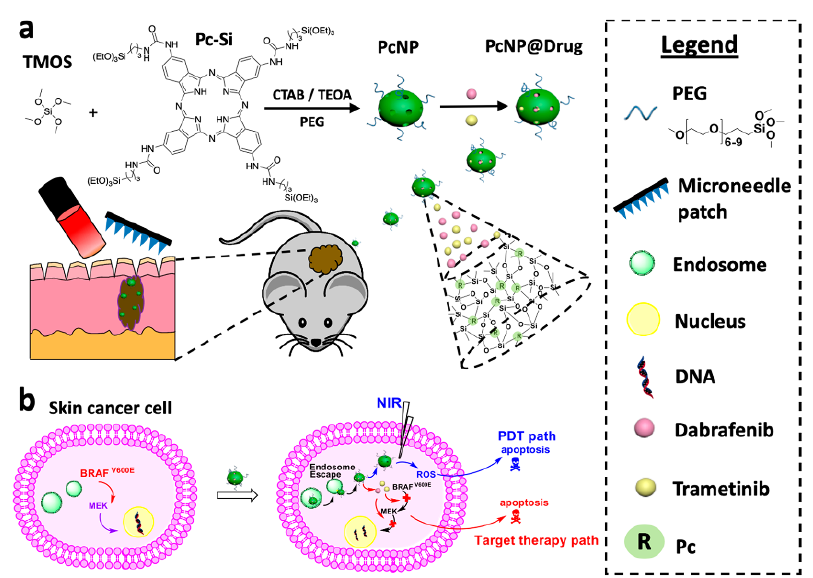
Figure 6. ( a ) PcNP@Drug synthesis and its skin penetration. Phthalocyanine was modified with four silicate units (Pc-Si), Pc units excited by far-red light and acting as photosensitizers, then the Pc-conjugated mesoporous organosilica nanoparticle (PcNP) was fabricated via silane co-condensation and hydrolysis using Pc-Si. In this process, hexadecyltrimethylammonium bromide (CTAB) acts as the structure-directing agent, triethanolamine (TEOA) acts as a basic catalyst and tetramethyl orthosilicate (TMOS) acts as the inorganic silica agent. To prepare PcNP@Drug, dabrafenib and trametinib, as small inhibitor drugs, were encapsulated into the PcNP pores. PcNP@Drug was then delivered to mice skin through a microneedle patch. ( b ) PcNP@Drug cellular uptake: under NIR light irradiation, PcNP@Drug produced reactive oxygen species (ROS) in-vivo and the drugs’ release of PcNP@Drug destroyed cancer cells. Reprinted with permission from [146] .